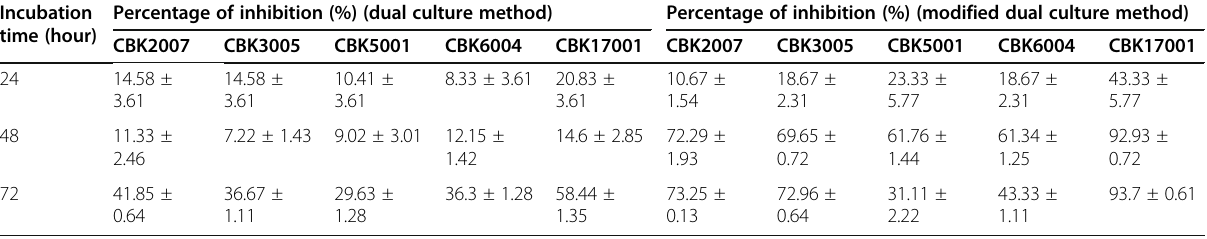
Table 2 Antifungal activity of bacterial isolates (CBK2007, CBK3005, CBK5001, CBK6004, and CBK17001) by dual culture method and modified dual culture method against Sclerotium rolfsii ( S . rolfsii ) (in percentage (%)) (results are expressed as means of three experiments and values are expressed as mean ± SD) Incubation Percentage of inhibition (%) (dual culture method) time (hour)